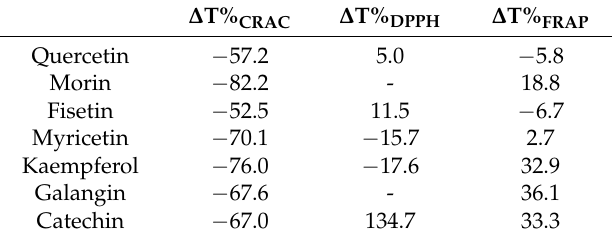
Table 3. TE value changes in proportion of different assays of antioxidant before and after complexation with BSA.